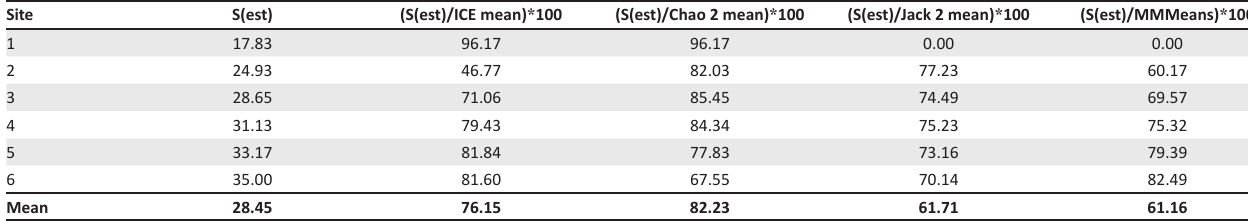
TABLE 3-A4: The reliability of each inventory was calculated for the control sites. Site